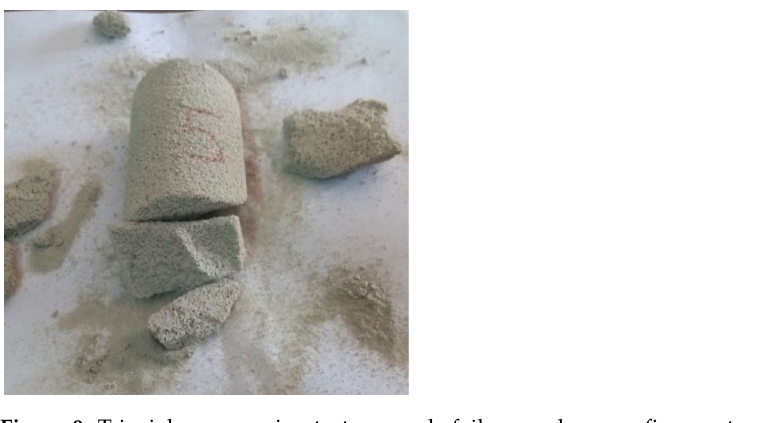
Figure 9. Triaxial compression tests: sample failure under a confinement equal to mean compres- sion